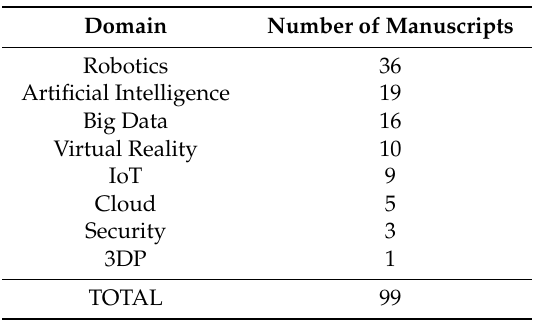
Table 1. References per